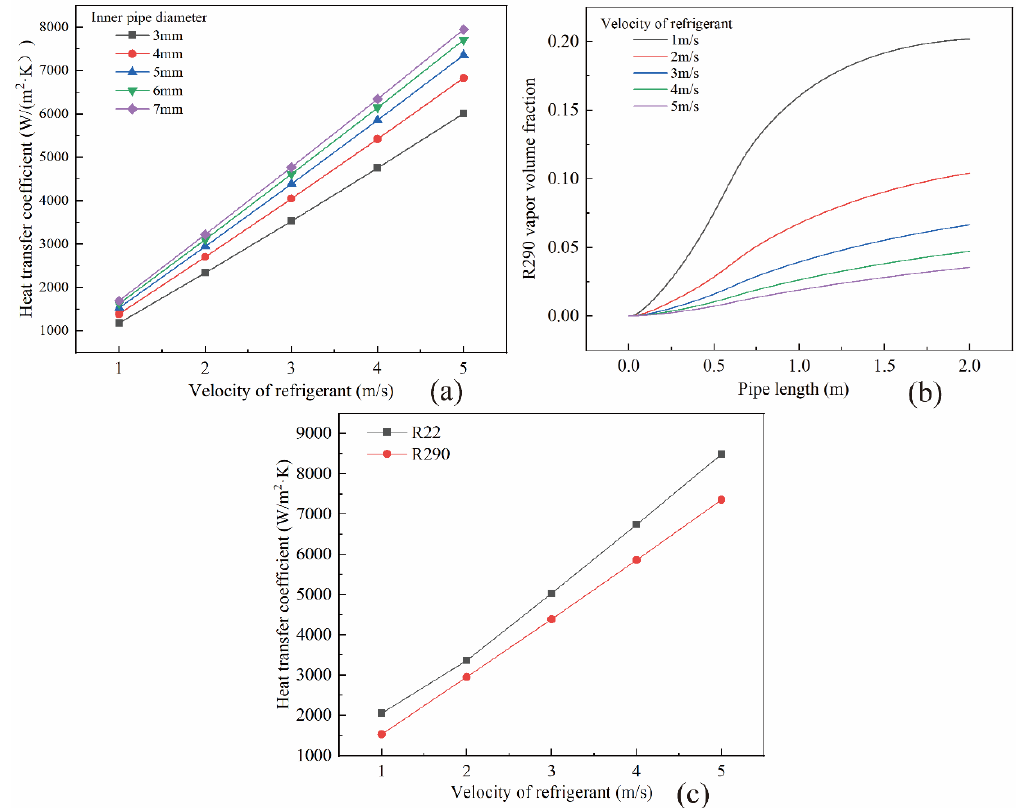
Figure 6. The impact of ( a ) refrigerant velocity on HTC, ( b ) R290 volume fraction at the inner tube wall surface and HTC for R22 and ( c ) R290 at different refrigerant velocities.